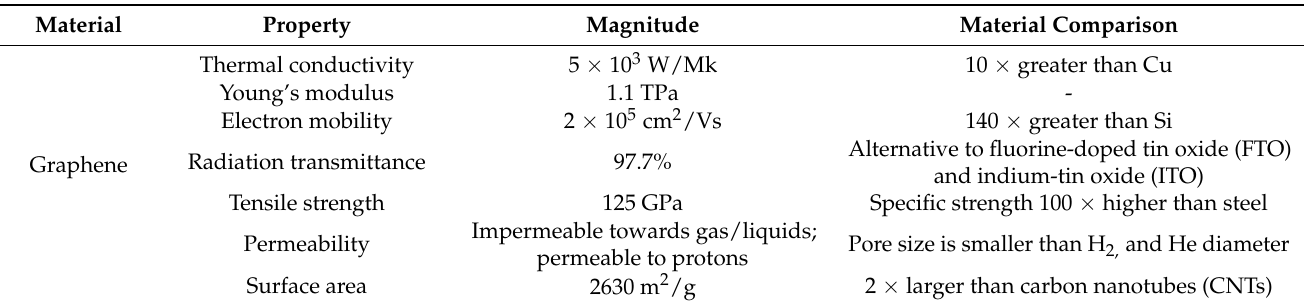
Table 3. Chemical and physical properties of graphene.